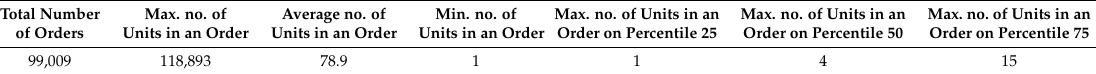
Table 2. Distribution of the number of units demanded in each independent order.